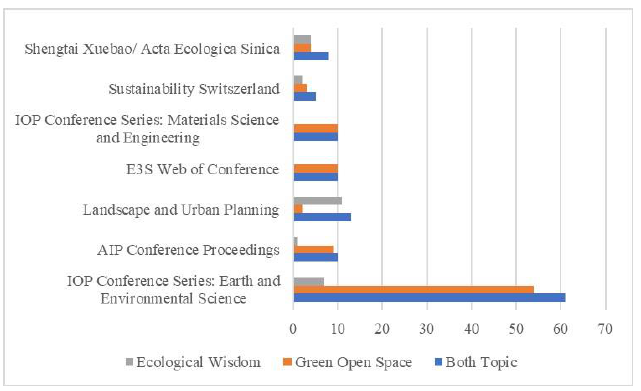
Fig. 2. The number of documents by source according to Scopus data